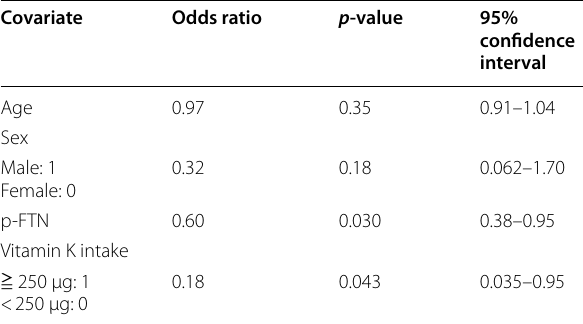
Abnormally high ucOC ( ≧ 4.5 ng/mL): 1, normal ucOC (< 4.5 ng/mL): 0